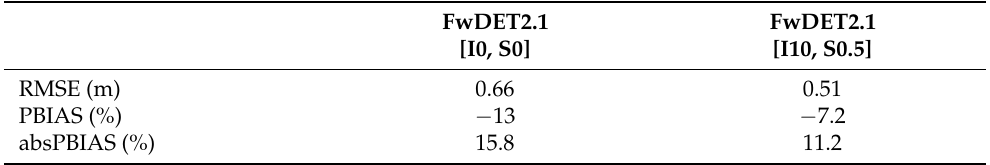
Table 5. Comparison statistics for the Brazos River case study for FwDET2.1 using 0 iterations and 0 slope [I0, S0] (equivalent to FwDET2.0; optimal NED results) and 10 iterations and 0.5 slope [I10, S0.5] (overall optimal) values.